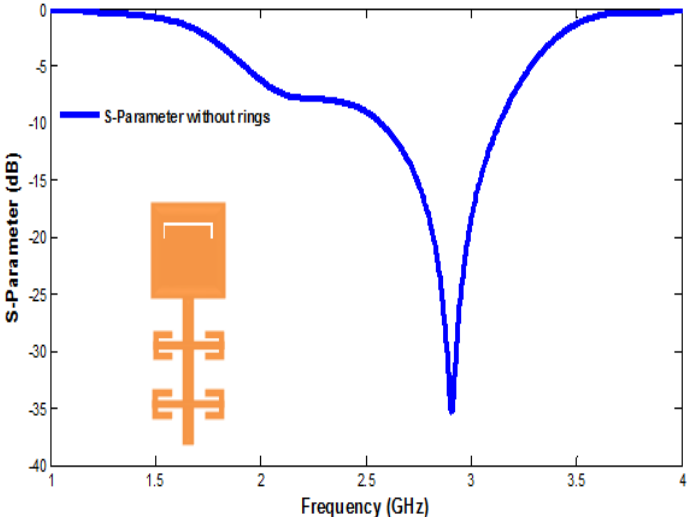
Figure 7. S 11 of the filtering antenna without a square open-loop ring resonator (SOLR).